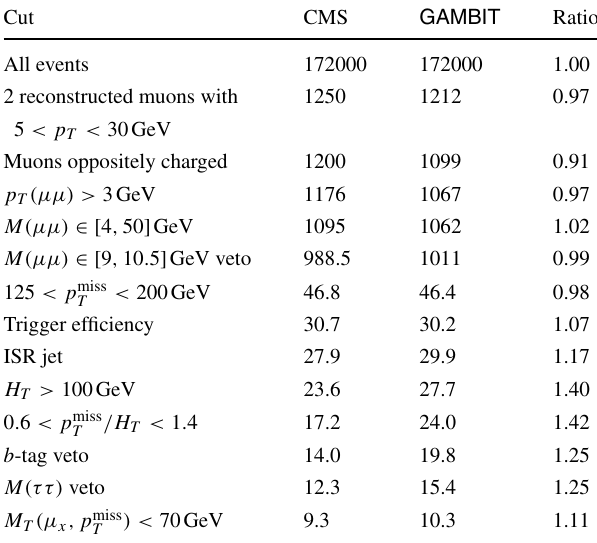
Table 5 Comparison of the GAMBIT and CMS [125] cutflows for a = 150GeV, m = 130GeV) in a search for W Z signal model ( m ˜ χ ± ˜ χ 0 1 1 new physics in events with two low-momentum opposite-sign leptons and missing transverse momentum. Shown are the numbers of events expected in 33.2fb − 1 of 13TeV CMS data for a signal cross-section of 5.18 pb [129]. Both the CMS cutflow and GAMBIT cutflow are generated for production of ˜ χ ±